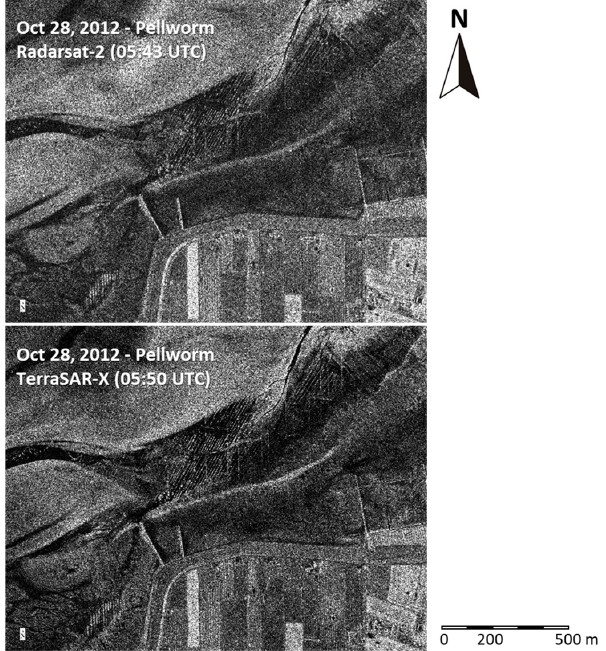
Figure 5. Radarsat-2 (upper) and TerraSAR-X (lower) SAR images of the same (1.7 km × 1.3 km) spot, north off Pellworm, acquired on 28 October 2012. Parallel diagonal lines in the images’ centers are remains of historical ditches. Radarsat-2 data and products © MacDonald, Dettwiler and Associates Ltd. 2012—All Rights Reserved; TerraSAR-X data © DLR 2012.